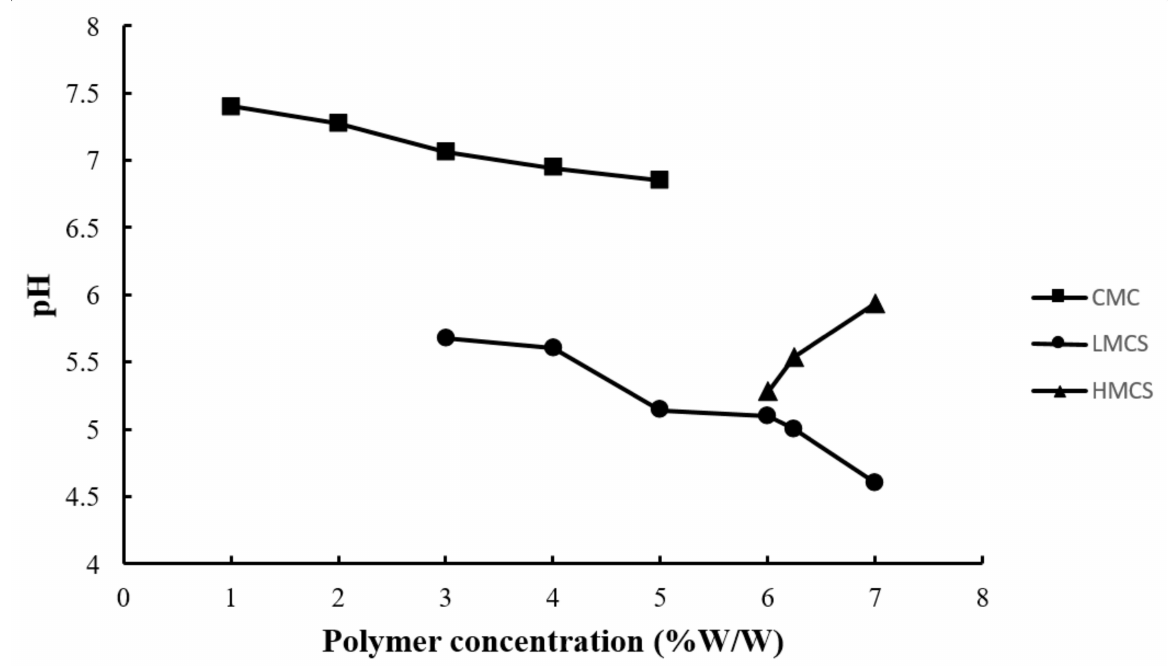
Figure 4. pH of the gels prepared from different concentrations of carboxymethyl cellulose (CMC), low molecular weight chitosan (LMCS), and high molecular weight chitosan